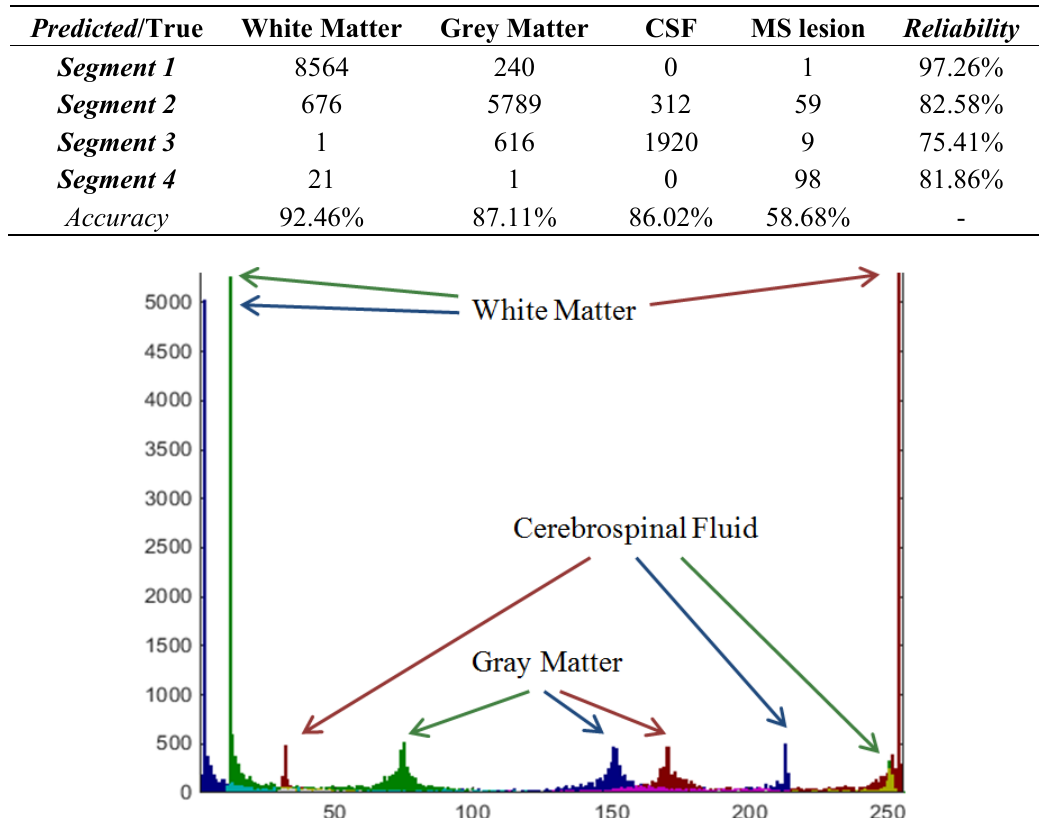
Figure 5. ( a ) Slice 95: IJM derived segmentation of the WM; ( b ) of the GM; ( c ) of the CSF; ( d ) of the MS lesions. Table 1. Confusion matrix for slice 95 using IJM image segmentation in Reference [16] with edge mask.